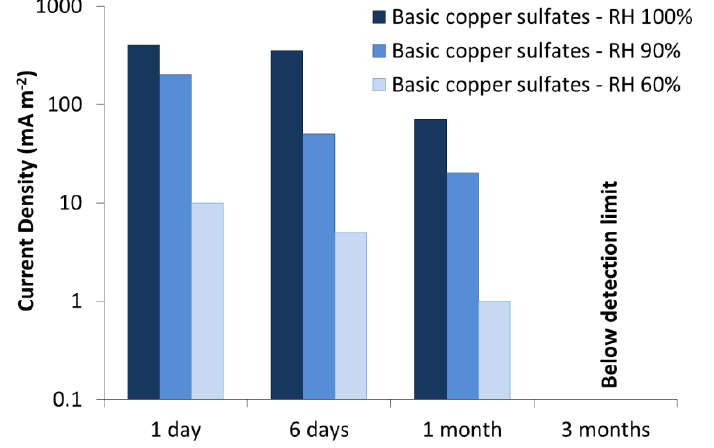
Figure 1. The galvanic sensors of the seventies [48,49]: macrocouple current as a function of time and relative humidity.